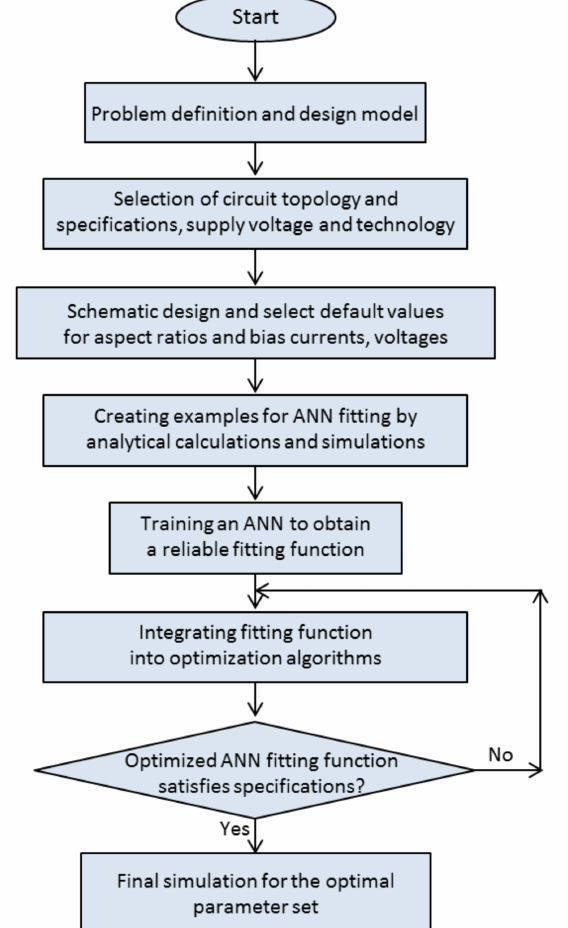
Figure 3. Flow diagram summarizing the protocol for determining the optimal set of circuit parame- ters that ensures minimal